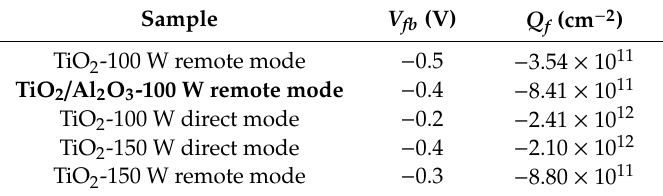
Table 2. V fb and Q f calculated by using Nicollian and Brews method and the Rajab model. Sample